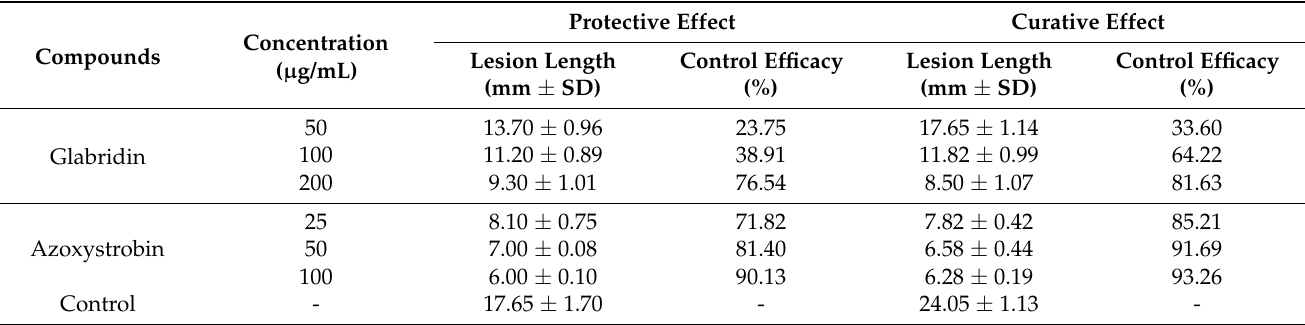
Table 3. In vivo fungicidal activity of glabridin against S. sclerotiorum .